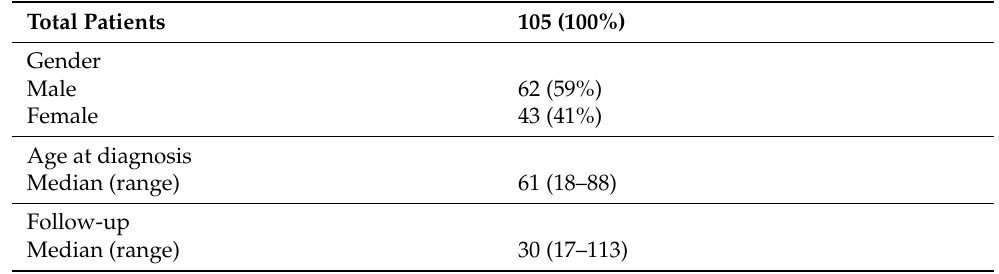
Table 1. Patient